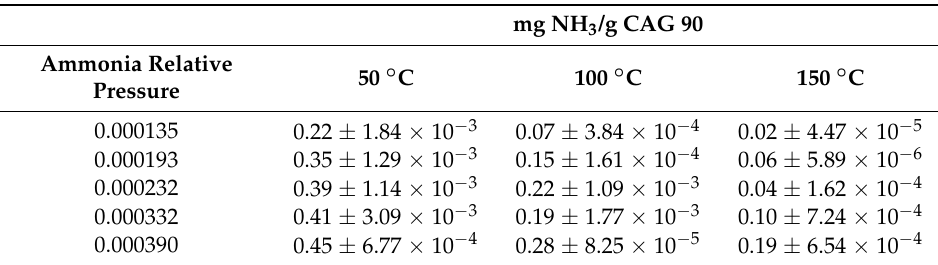
Table 8. Ammonia adsorbed over CAG 90 (mg NH 3 /g CAG